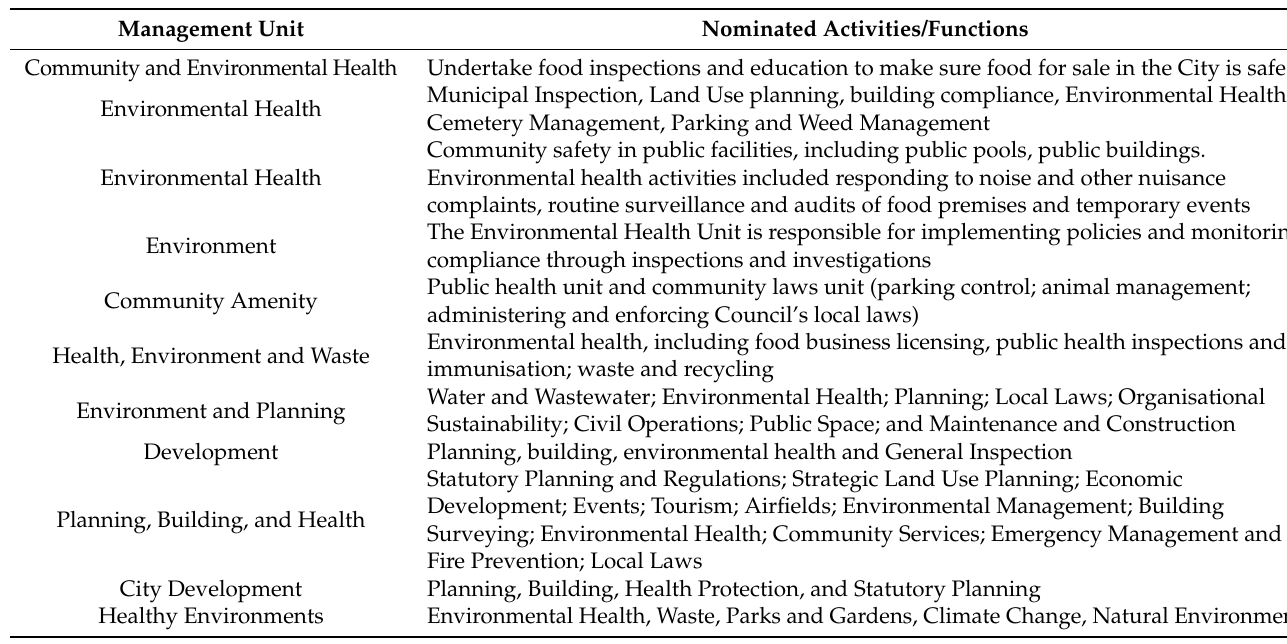
Table 3. Environmental health and associated sub-system